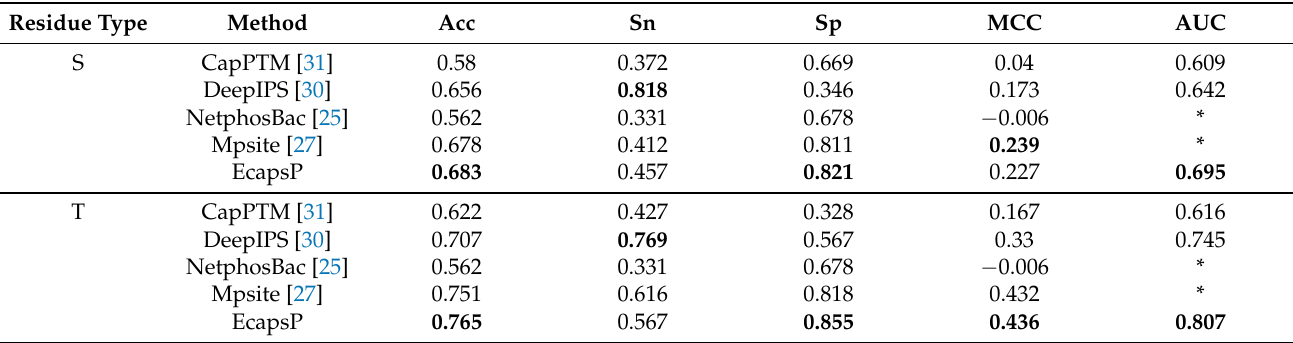
Table 4. Prediction performance of various models based on MPsite dataset. Due to the lack of open source models, the experimental data for MPsite and NetphosBac in the table are taken from the Md’s paper